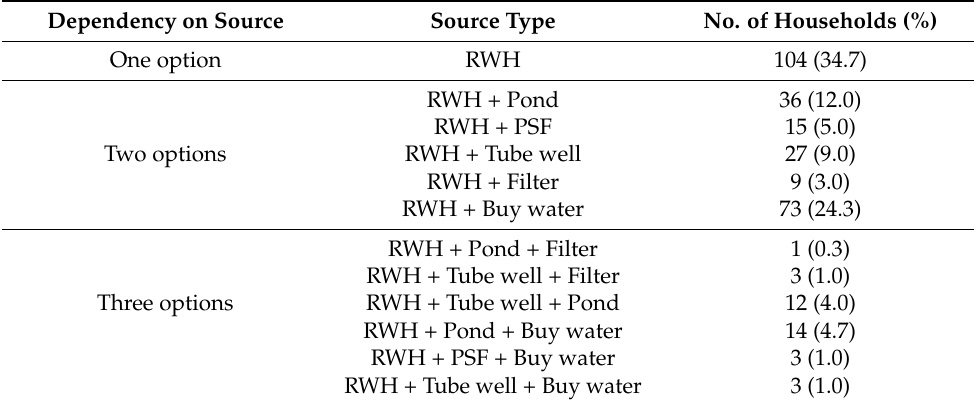
Table 2. Present drinking water options.